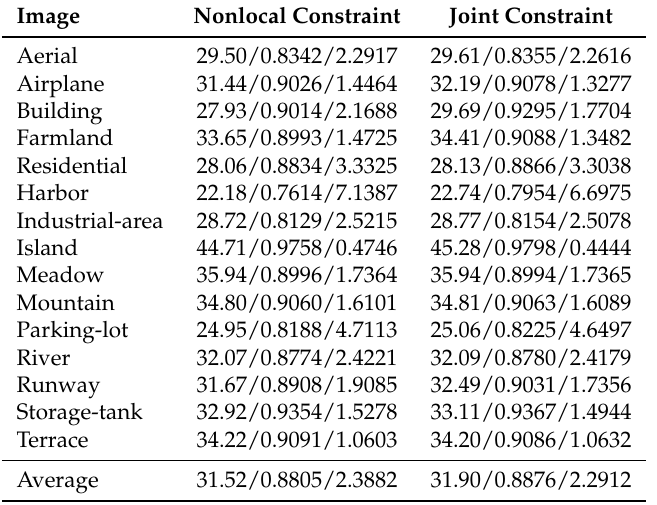
Table 7. PSNR/SSIM/ERGAS Results of Nonlocal and Joint constraints (Scale Factor = 3, Noise =